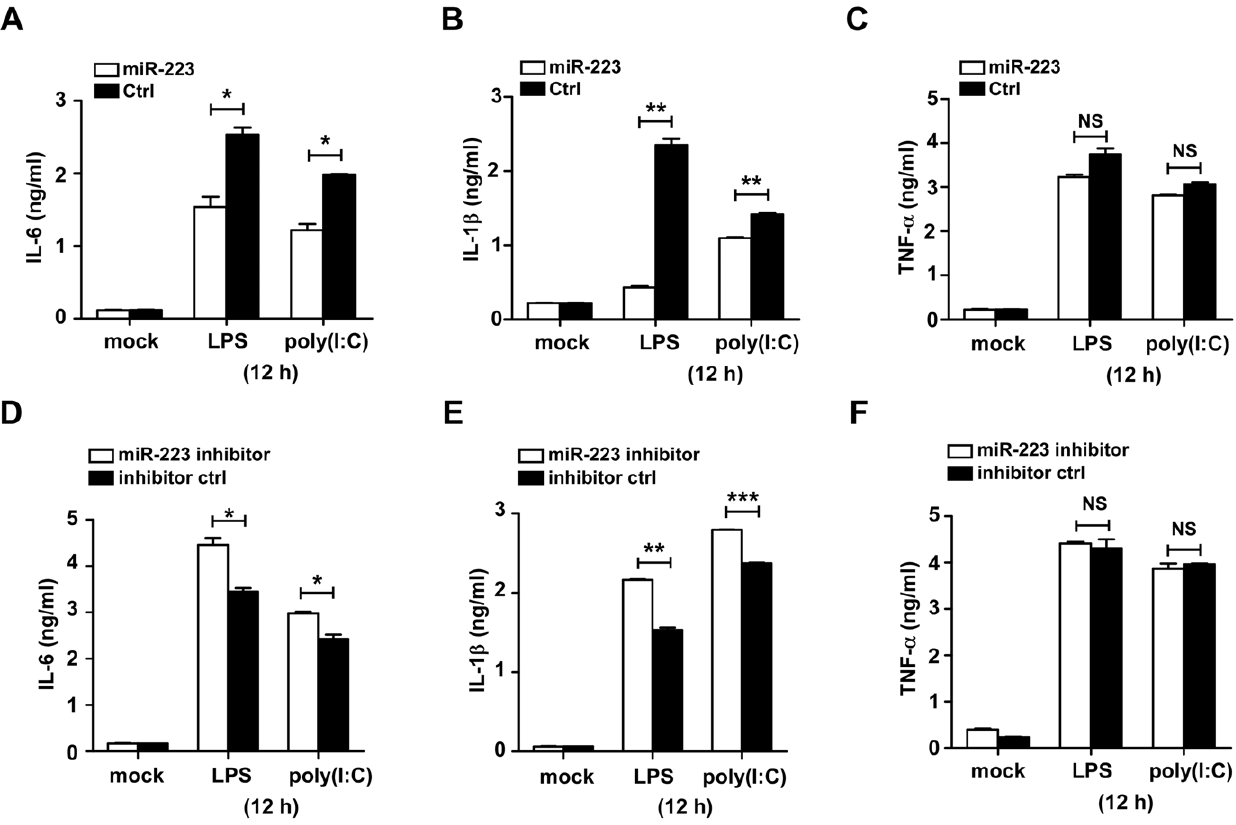
Figure 3. MiR-223 negatively regulates LPS or poly (I:C)-triggered IL-6 and IL-1 b production in macrophages. Raw264.7 cells were transfected with mimics or inhibitors of miR-223 and their controls at a final concentration of 30 nM. 24 h later, cells were stimulated with or without LPS (100 ng/ml) or poly (I:C) (10 m g/ml). (A–F) Supernatants were collected after 12 h to measure IL-6, TNF- a , IL-1 b by ELISA. Data are the mean 6 SD (n=3) of three independent experiments. *** p , 0.001; ** p , 0.01; * p , 0.05; NS, not